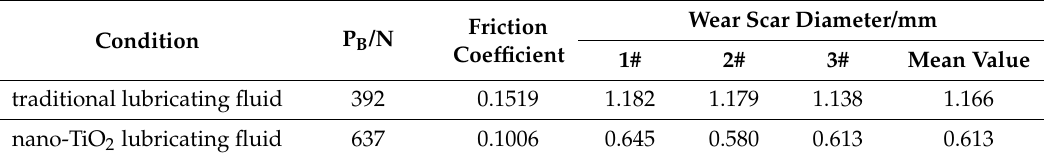
Table 3. Tribology performances of traditional lubricating fluid and nano-TiO 2 fluid.